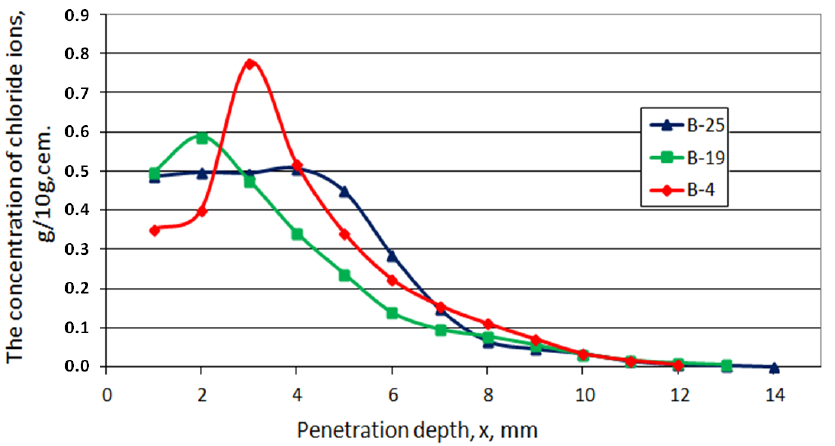
Figure 15. Concentration of free chloride ions in series B of hardened cement paste, depending on the transport way and immersion